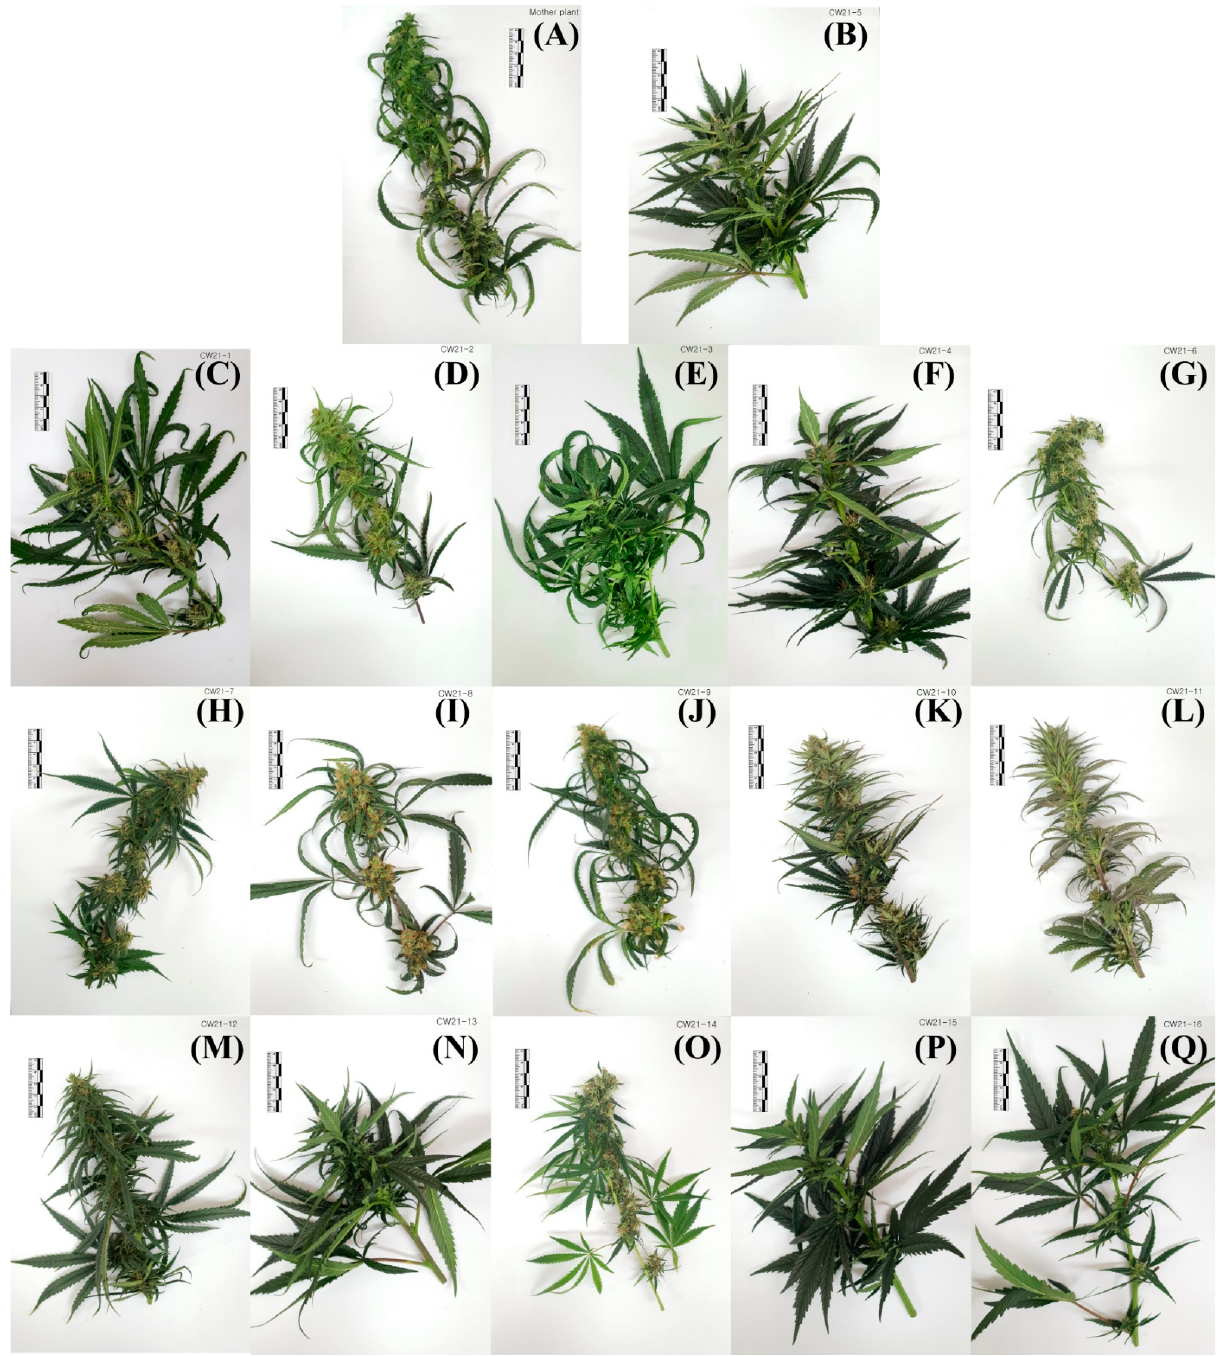
Figure 3. Branch tip shape of hemp mother plant and F1 hybrids. The samples were collected on day 50 of the flowering treatment (short light length, 12h light/day). ( A ) Mother plant; ( B ) CW21-5 line; ( C – Q ) F1 generation except CW21-5 line.